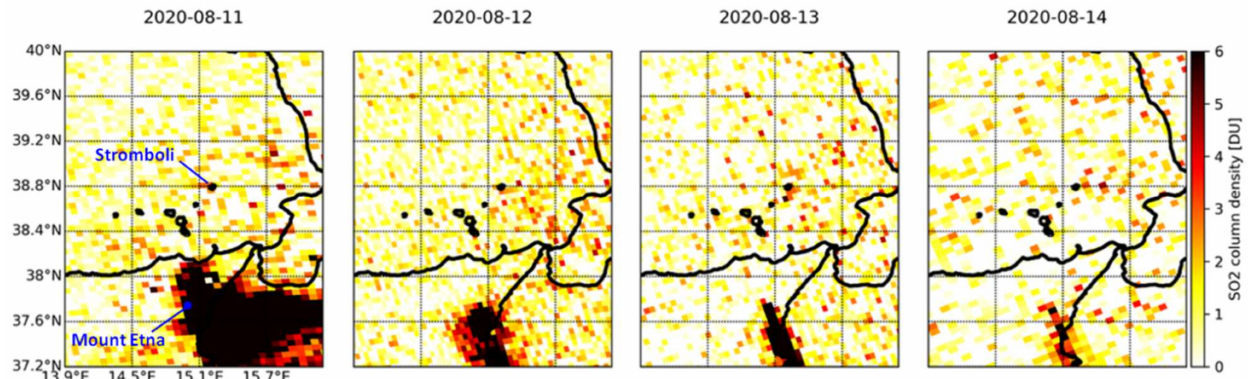
Figure 9. Time lapse of TROPOMI SO 2 column density observations over the Aeolian archipelago and north-eastern Sicily in the period 11–14 August 2020.